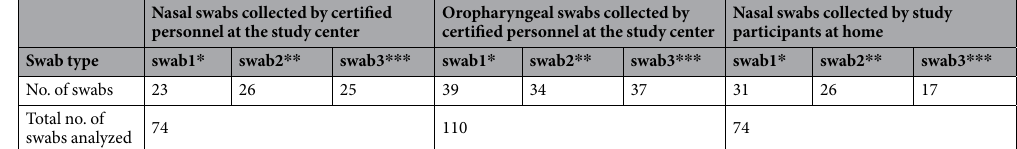
Nasal swabs collected by certified personnel at the study center